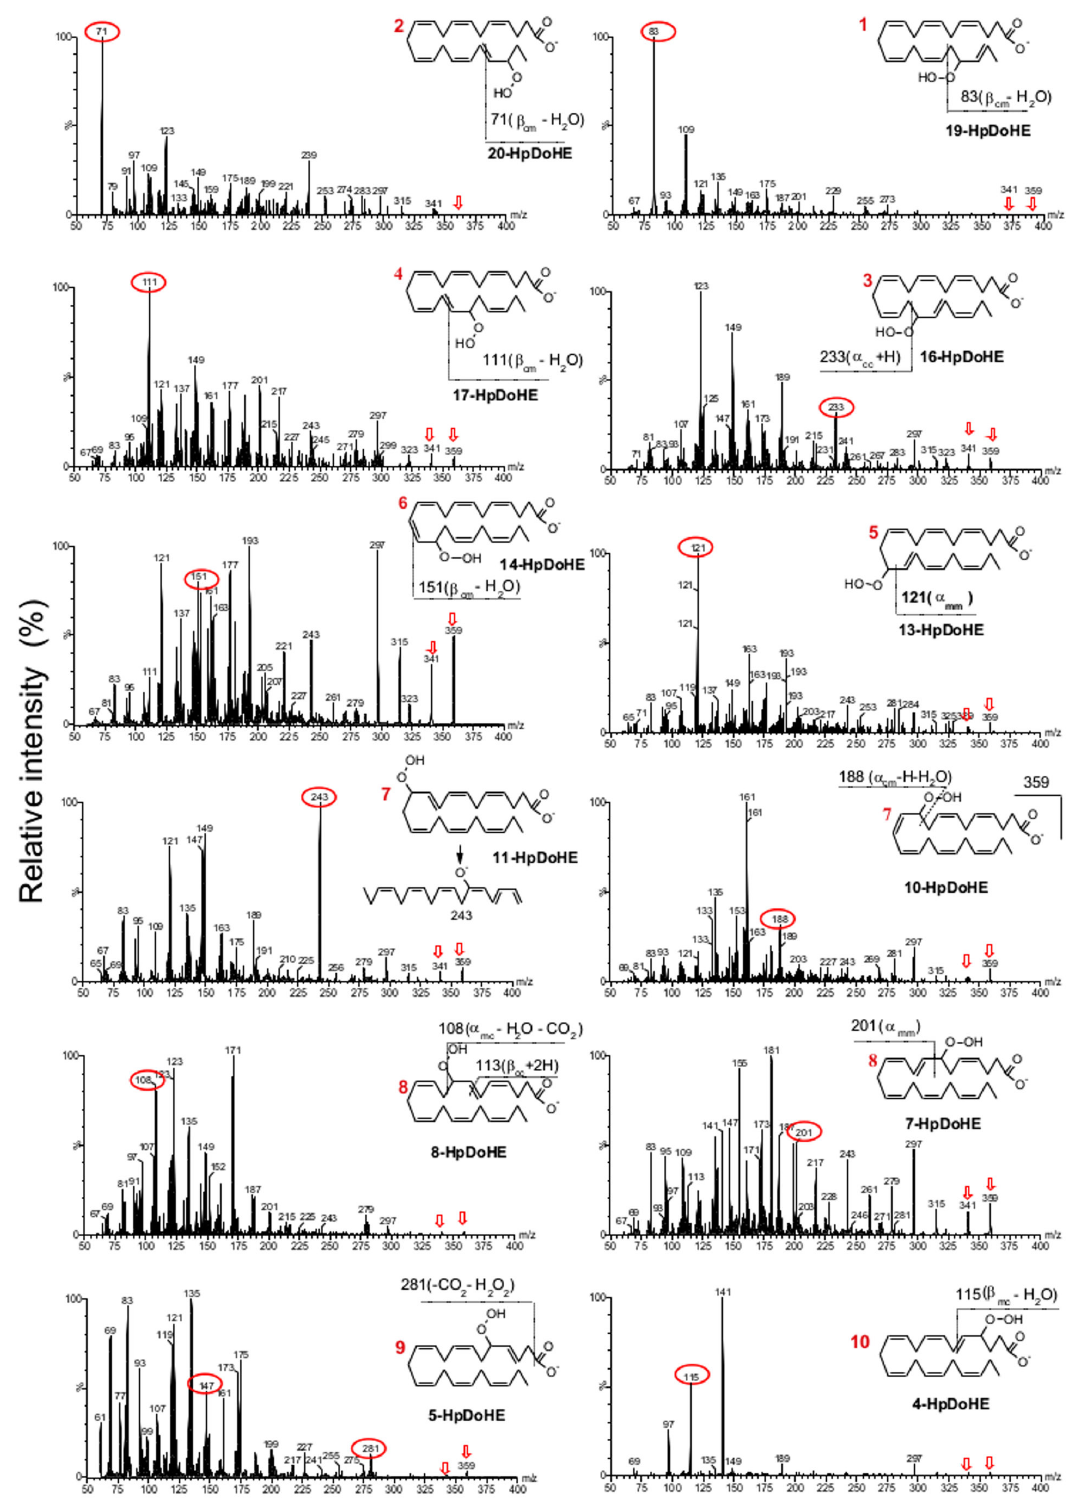
Figure 3. Fragmentation pattern analysis of the HpDoHE isomers – MS/MS spectra obtained from m/z 359. The selected fragments for SRM analysis are depicted in each isomer structure. The numbers in red correspond to the peaks observed in the LC- MS analysis (Figure 2). doi: 10.1371/journal.pone.0077561.g003 PLOS ONE |